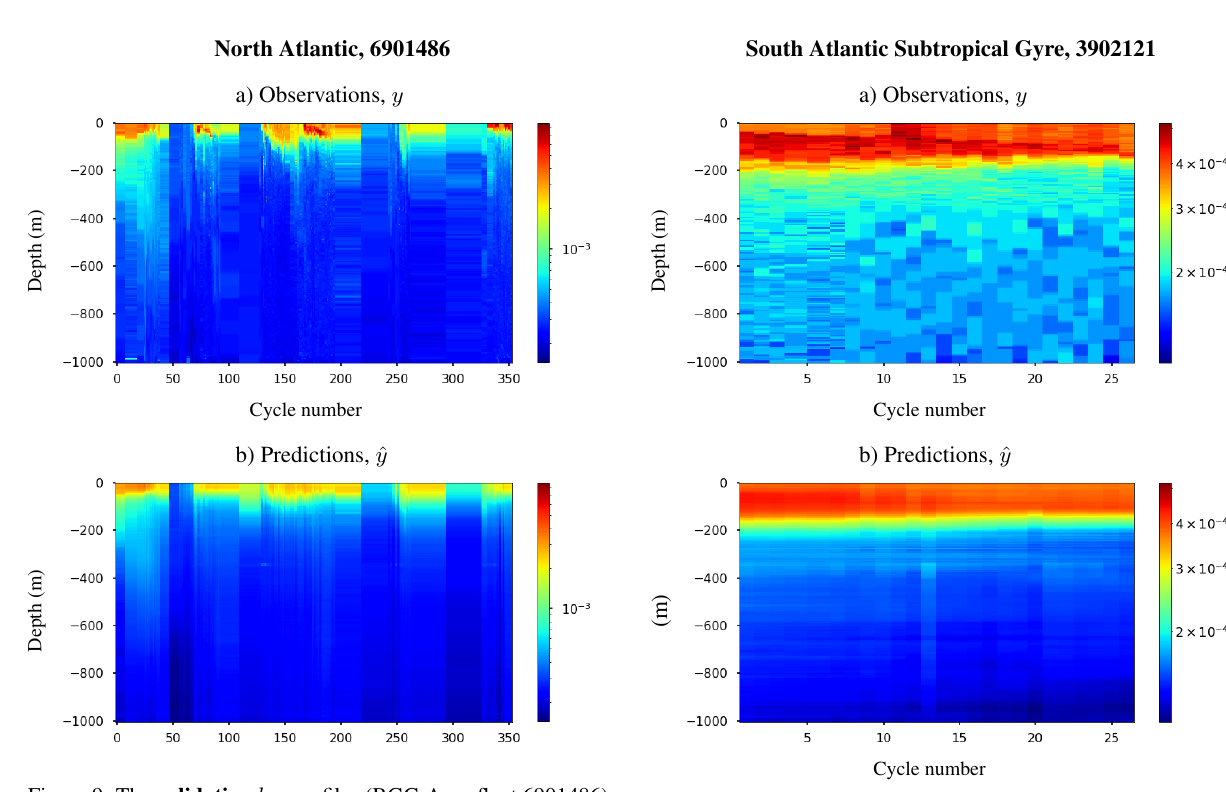
Figure 9. The validation b bp profiles (BGC-Argo float 6901486) Figure 10. The validation b bp profiles (BGC-Argo float as a function of depth and cycles (time) for the North Atlantic 3902121) as a function of depth and cycles (time) for the dataset. Panel a) shows the in situ b bp profiles measured from the Subtropical Gyre dataset. Panel a) shows the in situ b bp profiles float and panel b) shows the predictions from the Random Forest measured from the float and panel b) shows the associated regressor model. predictions from the Random Forest regressor